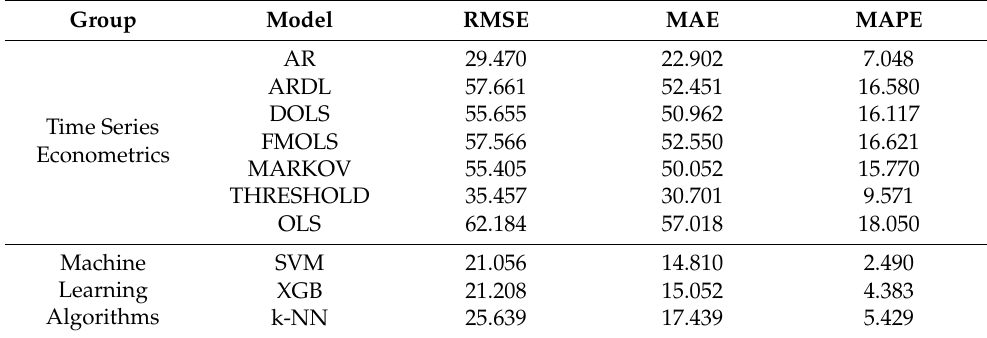
Table 3. Prediction performance comparison of alternative models in the pandemic period.